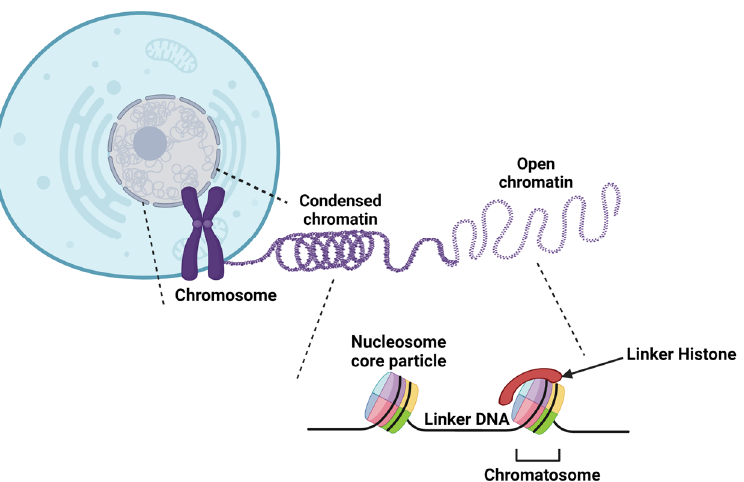
Figure 1. Overview of the different levels of DNA compaction. The first higher-order structure of the chromatin is the nucleosome, which is composed of 145–147 bp of DNA wrapped around a H3/H4 tetramer and two H2A/H2B dimers. The histone H1 linker binds DNA fragments that link two nucleosomes to form the chromatosome. The addition of H1 promotes internucleosomal inter- actions and the formation of the 30 nm chromatin fiber. The highest level of DNA compaction is the metaphasic chromosome, observable during cell